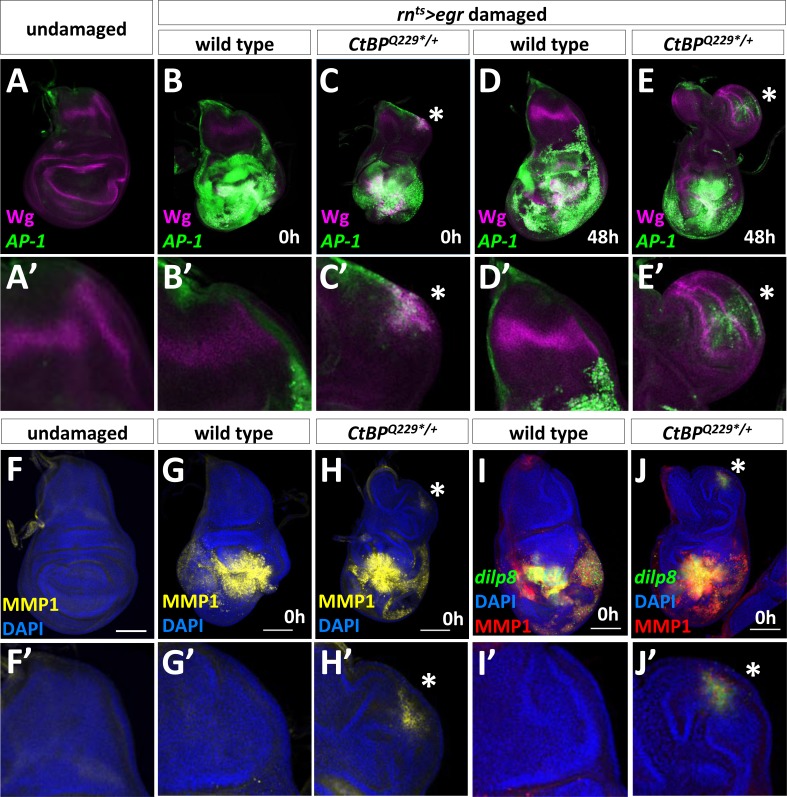
JNK activity at secondary location in the notum and in the ectopic pouch.(A–E) AP-1-RFP reporter and anti-Wg in undamaged (A) and rnts>egr damaged (B–E) wing discs following 0 hr and 48 hr of recovery in wild type (B, D) and CtBPQ229*/+ (C, E) genetic backgrounds. AP-1-RFP reporter is shown in green and anti-Wg is in magenta. (F–J) JNK target MMP-1 in undamaged (F) and rnts>egr damaged (G–J) wing discs following 0 hr of recovery in wild type (G, I) and CtBPQ229*/+ (H, J) genetic backgrounds. The dilp8-GFP reporter (dilp8MI00727) expression largely overlaps with the area of MMP-1 expression in the regenerating wing pouch (I, J) and at the secondary location in the notum (J’). Regions of the notum are enlarged in (F’–J’) and asterisks mark areas of increased JNK activity in the notum and ectopic pouch.